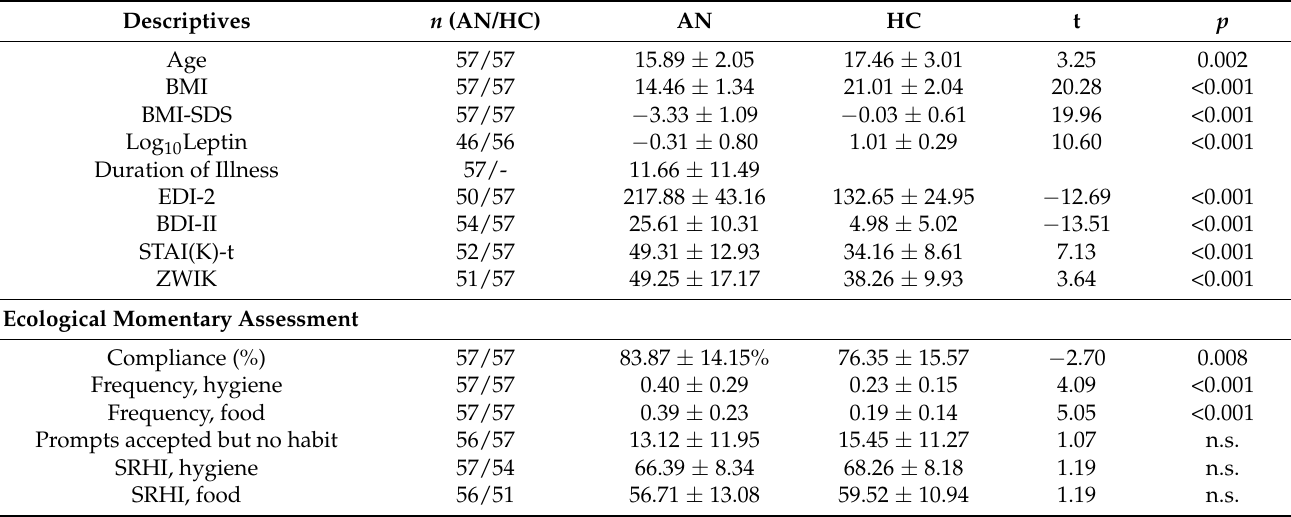
Table 1. Descriptive sample